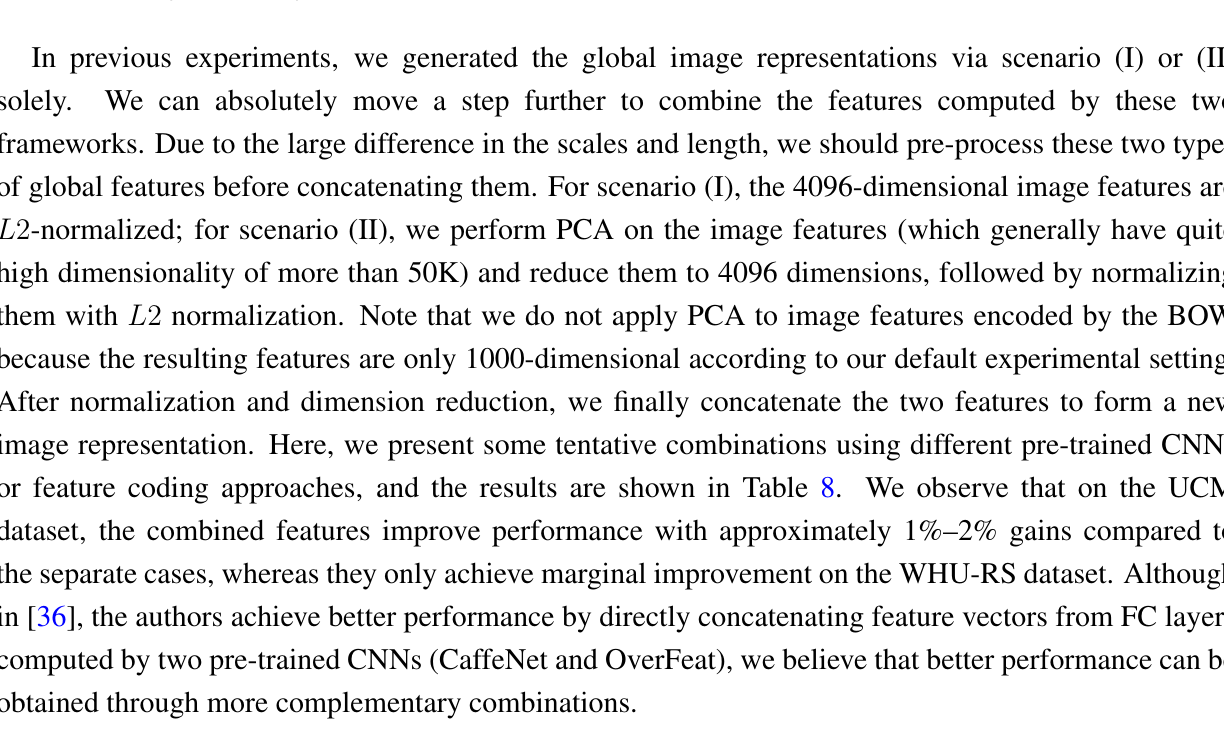
Table 8. Performance of Combining Features Generated by the Two Scenarios (I) and (II). Some Tentative Combinations are